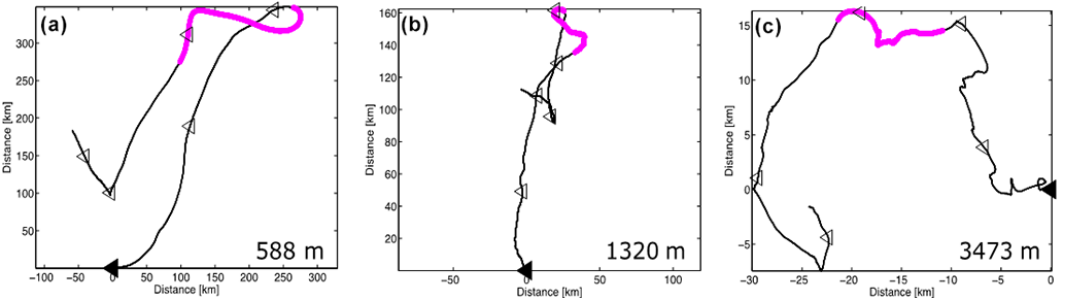
Figure 2. Progressive vector diagram (PVD) of 48h low pass filtered current meter records at (a) 588m, (b) 1320m, and (c) 3473m for the period from 1 December 2009 (filled triangle at 0.0) to 1 May 2010. The segment in each PVD that corresponds to the ACME passage is indicated by the magenta dots. Open triangles indicate the trap sampling intervals of 29 days. Note, for the deep trap current meter, that the speed failed shortly after installment, and a constant speed of 1.1cms − 1 was used throughout the